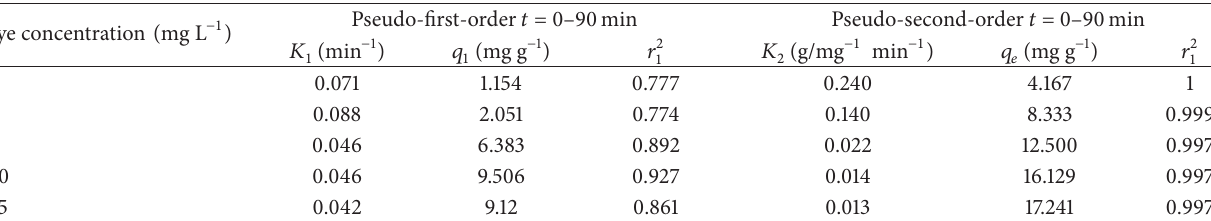
Table 7: Kinetics parameters for the adsorption of AB1.